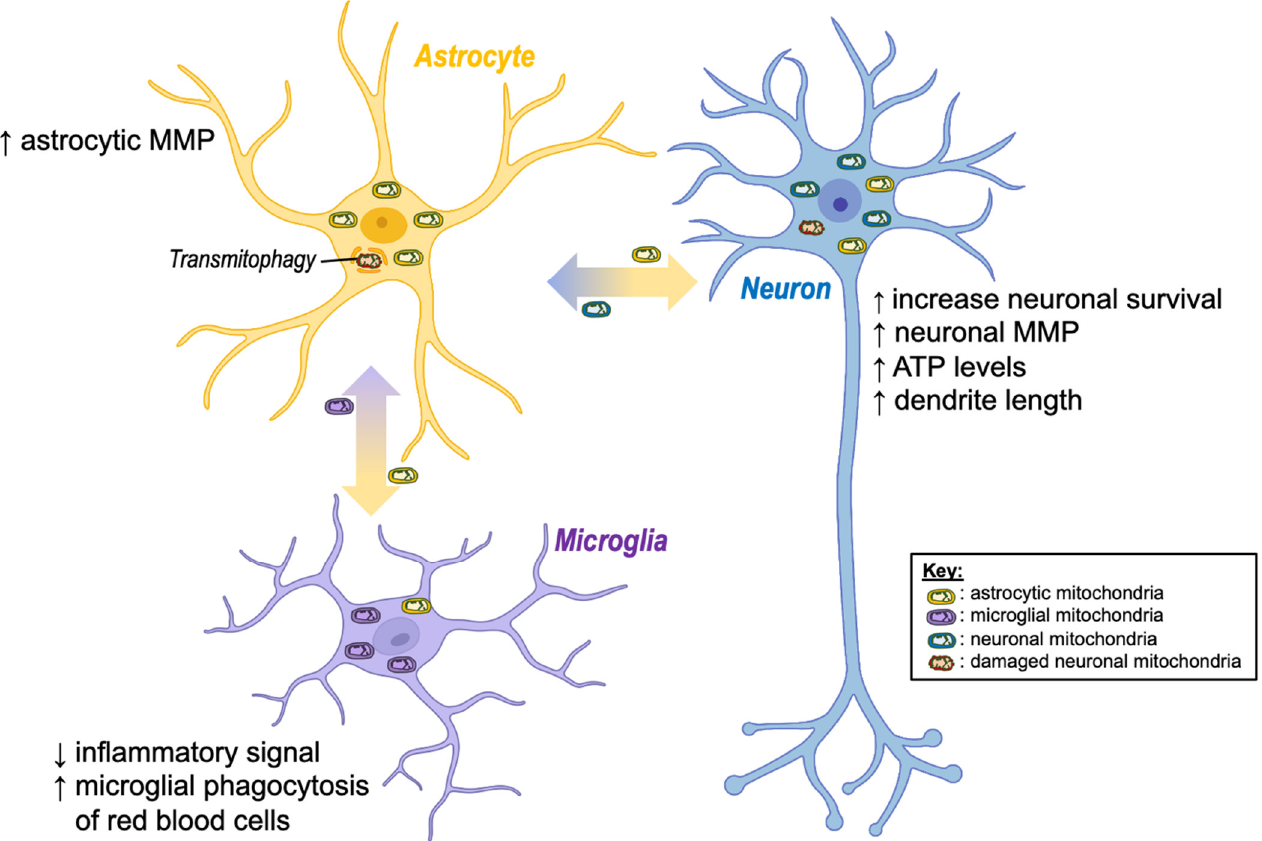
Figure 2. Beneficial effects of intercellular mitochondria transfer in the brain. Regardless of the mode of transfer (extracellular vesicles or tunnelling nanotubes), exchange of mitochondria between brain cells has shown positive effects. Namely, the transfer of healthy astrocytic mitochondria to stressed neurons (e.g., after a stroke) seems to increase neuronal viability, dendrite outgrowth, and bioenergetics (ATP, MMP), while damaged neuronal mitochondria are degraded by astrocytes. Moreover, transfer of mitochondria from astrocytes to microglia appears to reduce inflammation and increase microglial phagocytosis. ↓ decrease; ↑ increase; ATP, adenosine triphosphate; MMP, mitochondrial membrane potential. Created with BioRender.com (accessed on 7 November 2022).